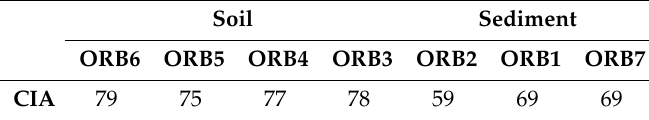
Table 6. Chemical Index of Alteration (CIA)